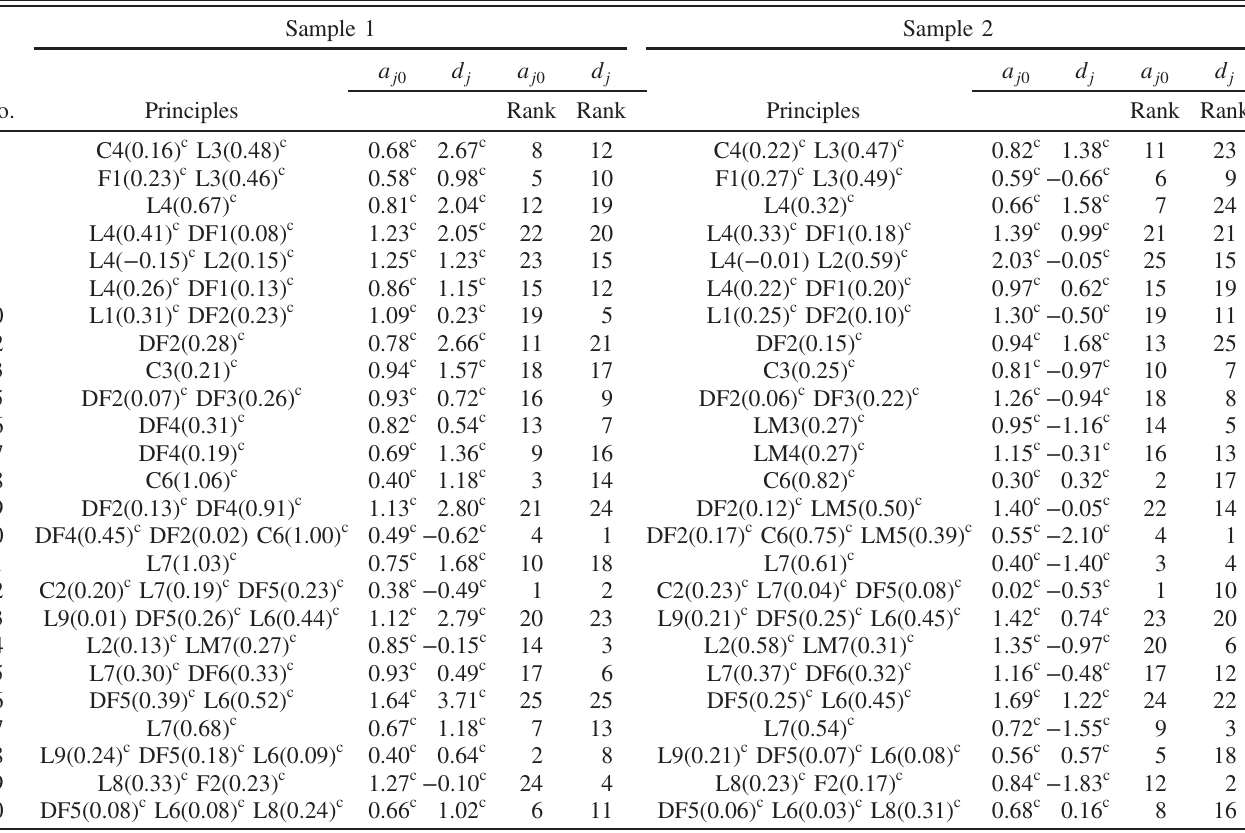
TABLE IV. Optimal MIRT model for samples 1 and 2. The first column shows the CSEM item number (No.). Not all CSEM items were modeled. The number in parenthesis is the discrimination a jk for principle k of item j . a j 0 is the discrimination for a factor loaded on all items and d j is related to the overall difficulty of the item. Both parameters are also rank ordered from smallest to largest. The significance of a t test with Bonferroni correction to determine if the difficulty and discrimination are different from zero is reported as a superscript. A superscript of “ a ” represents the corrected equivalent of p < 0 . 05 , “ b ” p < 0 . 01 , and “ c ” p < 0 . 001